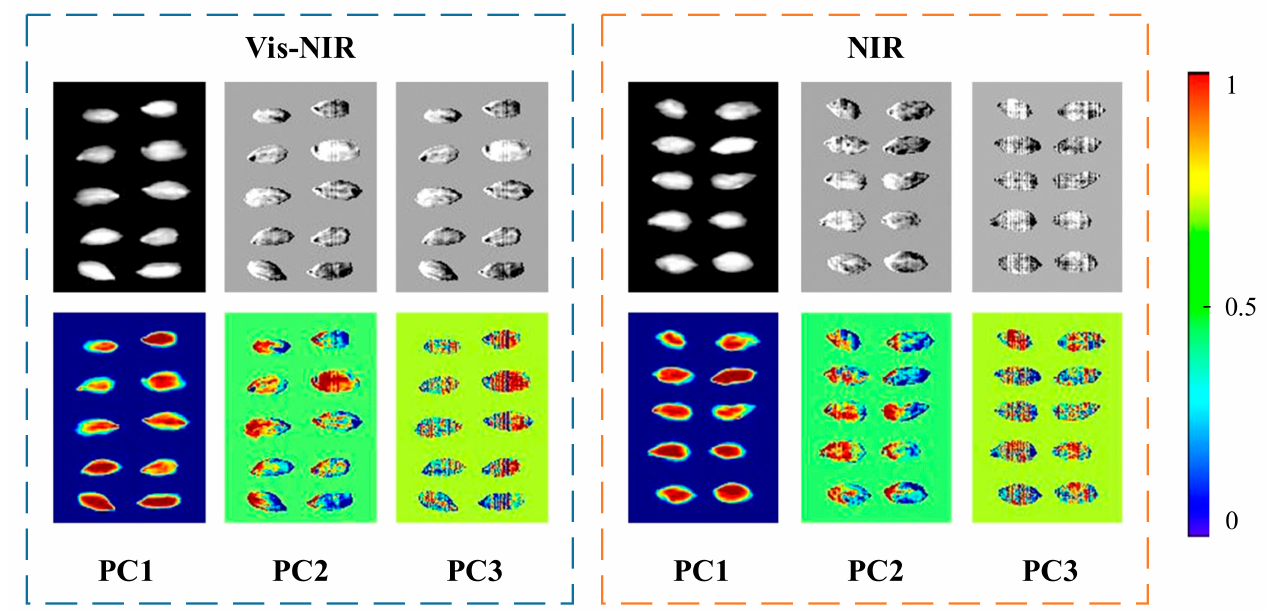
Figure 6. PCA of pseudo-color visual